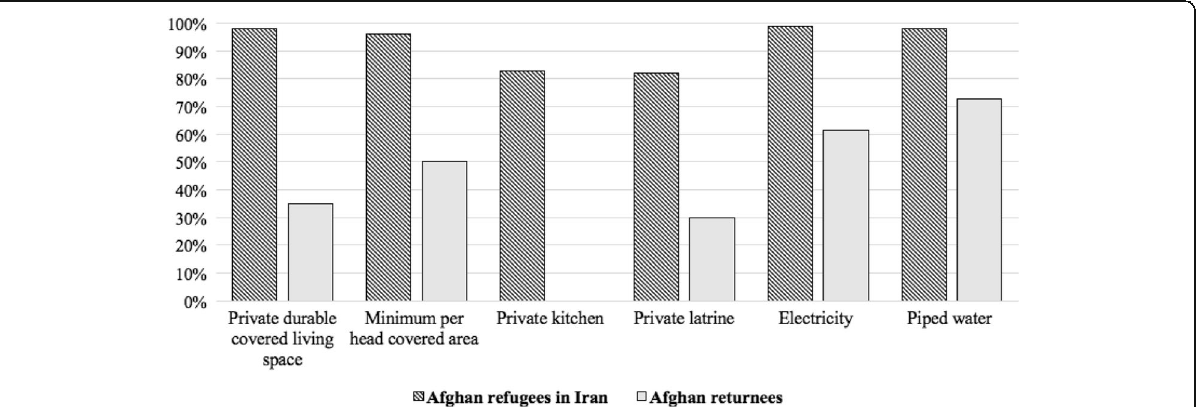
Fig. 1 Comparison of Afghan refugees ’ and returnees ’ housing and standards of